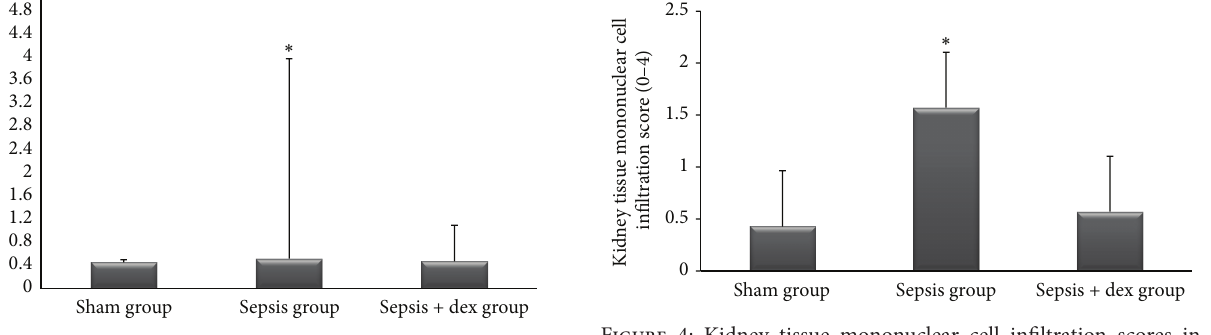
Figure 1: Serum creatinine levels in experimental groups. ∗ 𝑃 < 0.05 compared with sham and sepsis + dex groups.